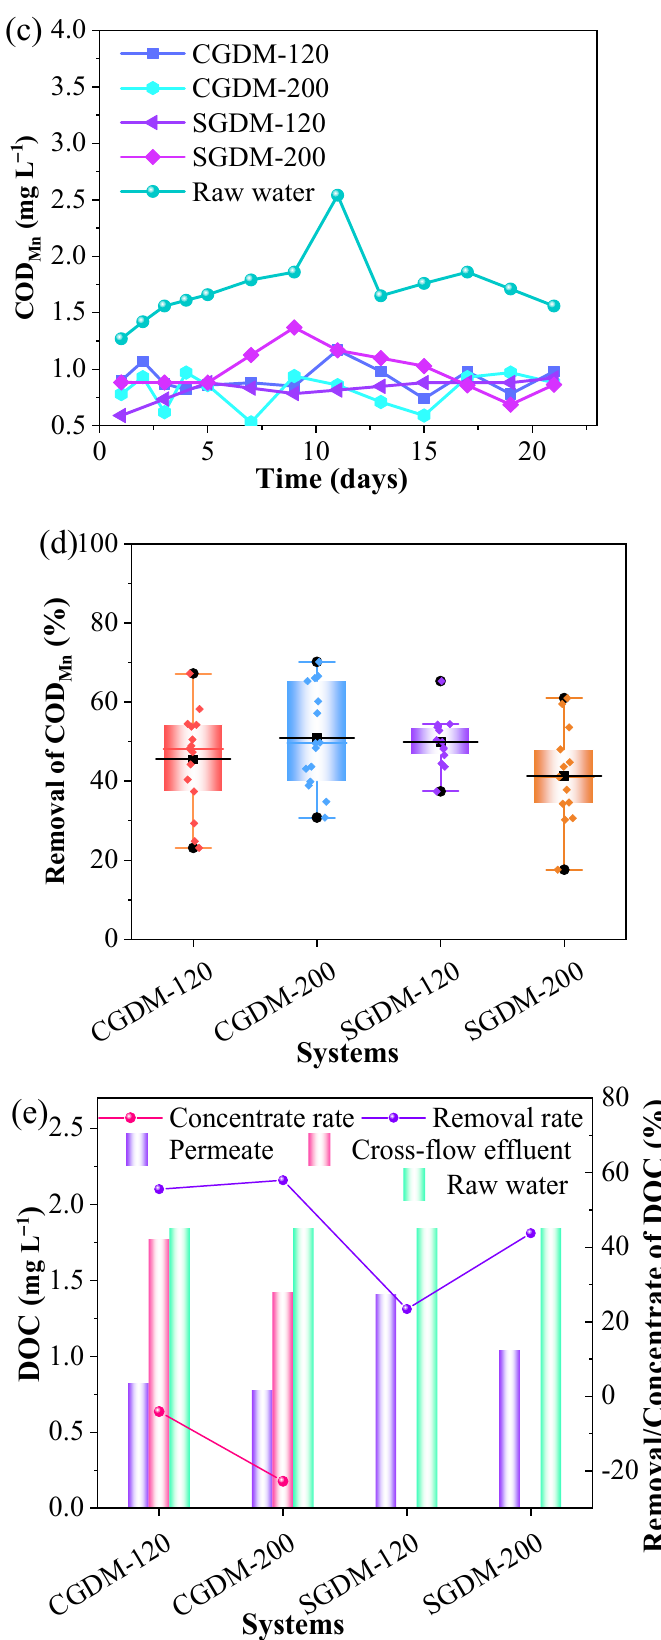
Figure 4. Removal performance of organic matters: ( a ) trend of UV 254 , ( b ) removal rate of UV 254 , ( c ) trend of COD Mn , ( d ) removal rate of COD Mn , ( e ) removal performance of DOC.